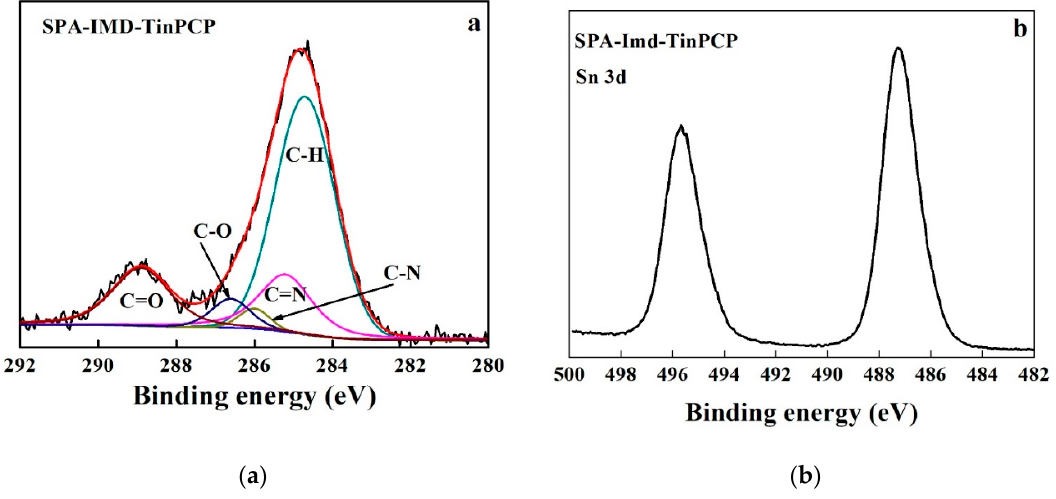
Figure 4. ( a ) C 1s spectra for SPA-Imd-TinPCP; ( b ) Sn 3d spectra for SPA-Imd-TinPCP.